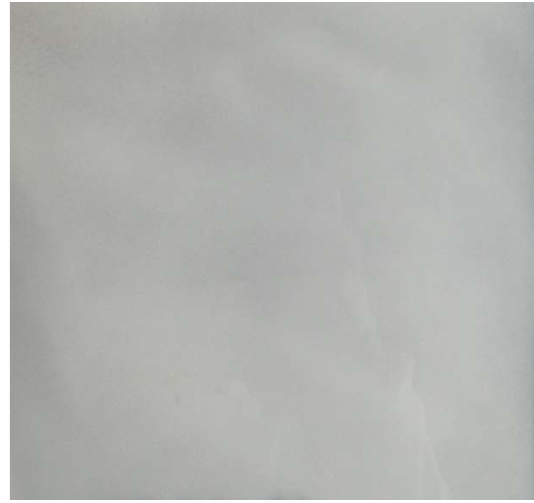
Fig. 14 Sample with the EVA 1 and paint sprayed on the glass after the aging